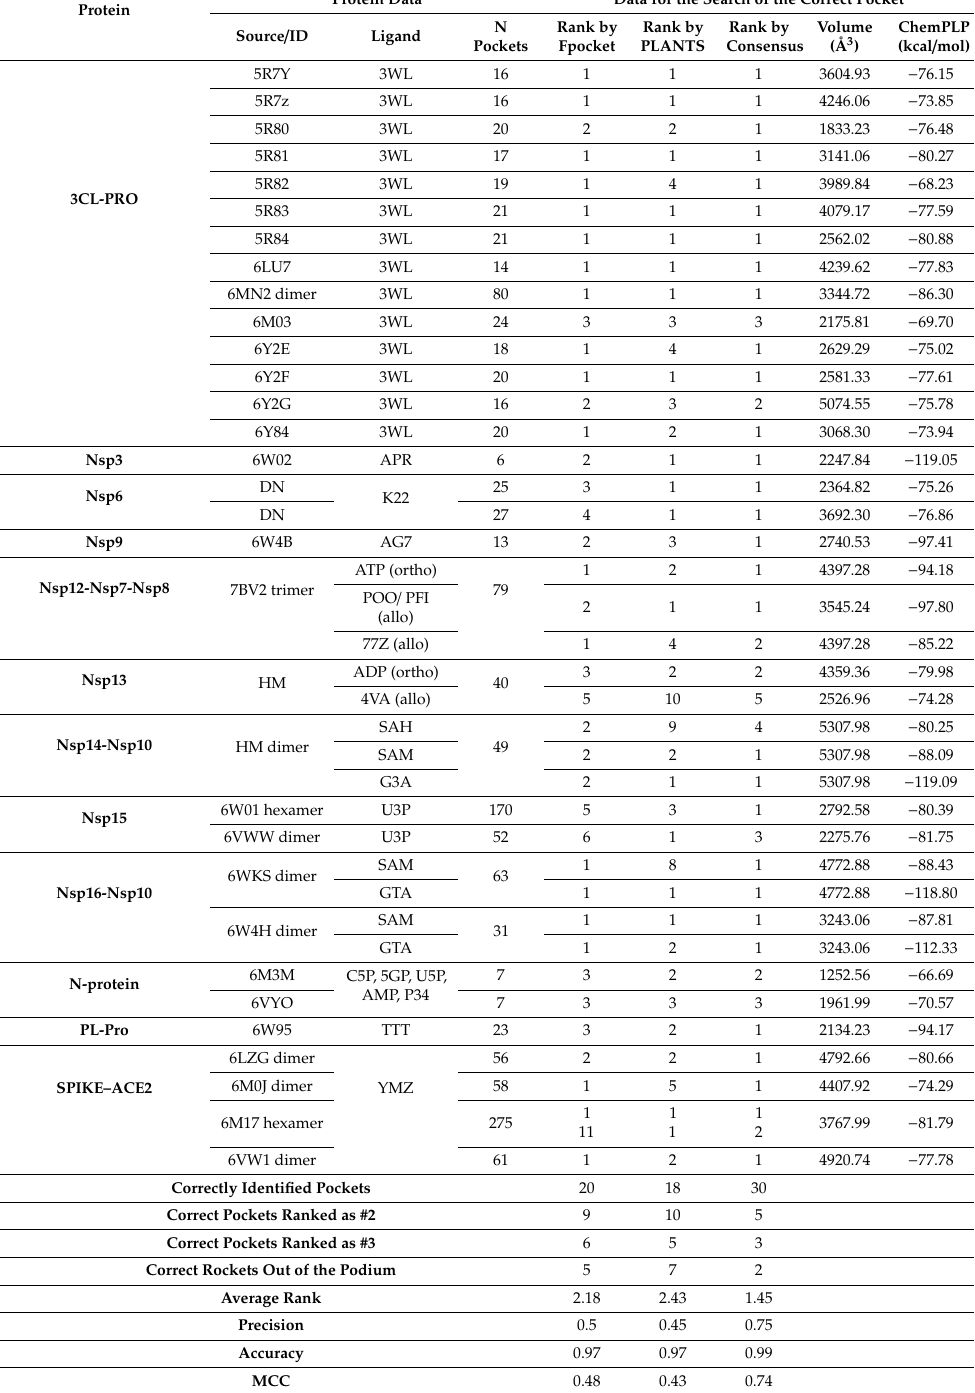
Table 2. Results of the pocket analysis as performed by Pockets 2.0 on the therapeutically relevant protein targets. The first part of the Table includes data concerning the overall search (such as the source of the analyzed protein, the probe ligand and the number of found pockets), while the second part comprises data concerning the search for the correct pocket. In detail, the Table reports how the correct pocket was ranked by FPocket and PLANTS alone and by consensus score, which combines both searches. The volume and the ChemPLP score for the correct pocket are also